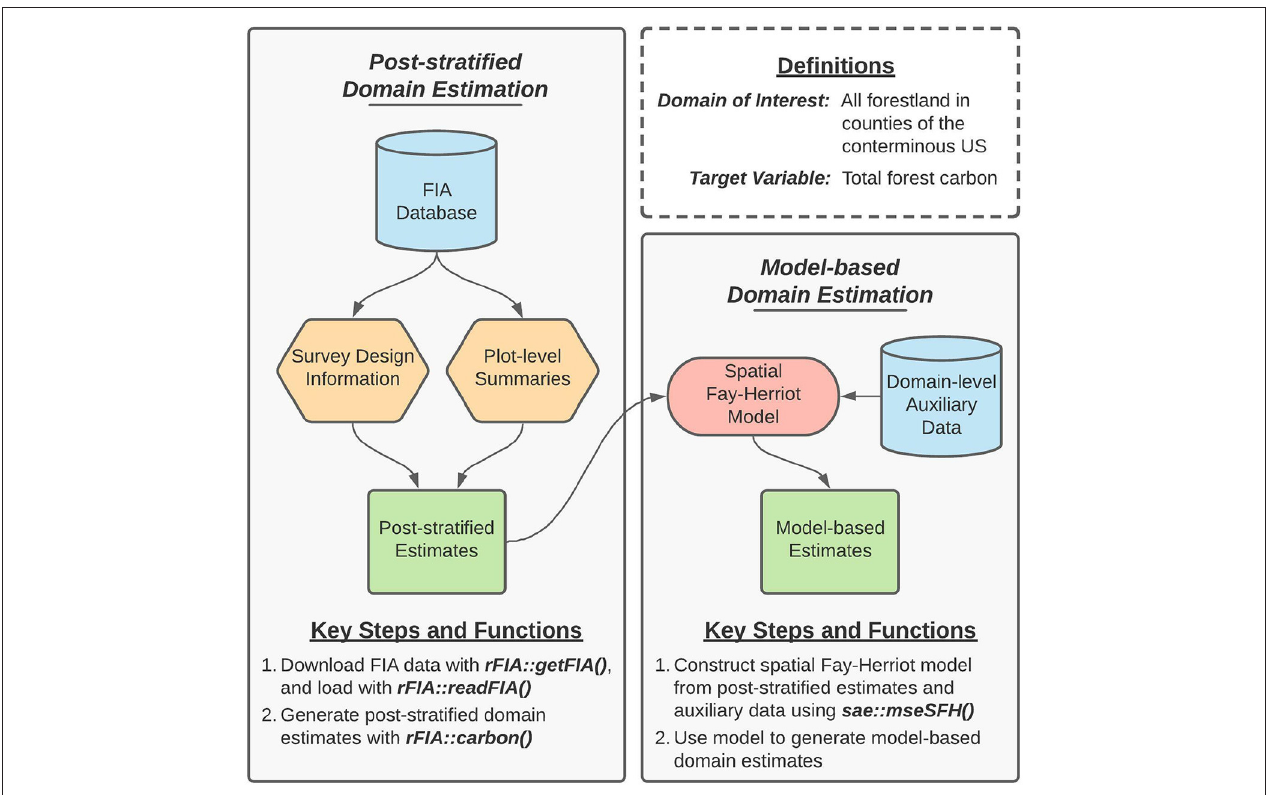
FIGURE 1 | Concept map illustrating key steps, functions, and workflows used in the development of our spatial Fay-Herriot model of forest carbon stocks in conterminous US. Here, blue cylinders represent data inputs, orange hexagons represent intermediate data products, red ovals represent models, and green rectangles represent domain